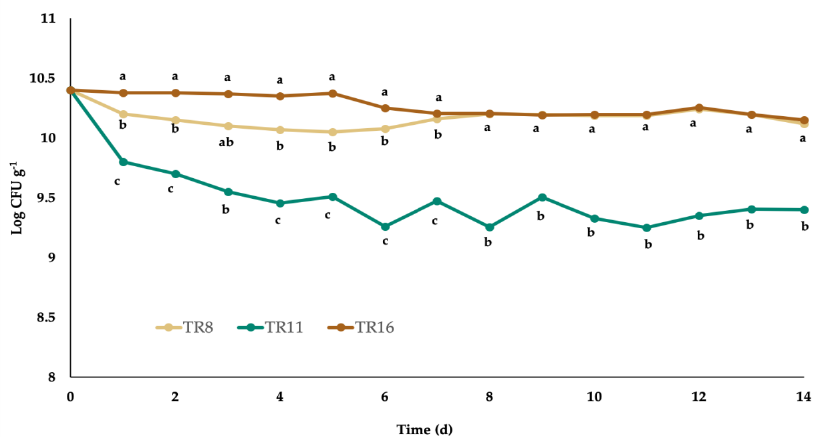
Figure 2. Viability of the TEP6 bacteria incorporated into films stored at room temperature. TR8: (100% A. vera , pH 4.5), TR16: (100% A. vera , pH 5.5), TR11: (70% chitosan and 30% A. vera , pH 5.5). The